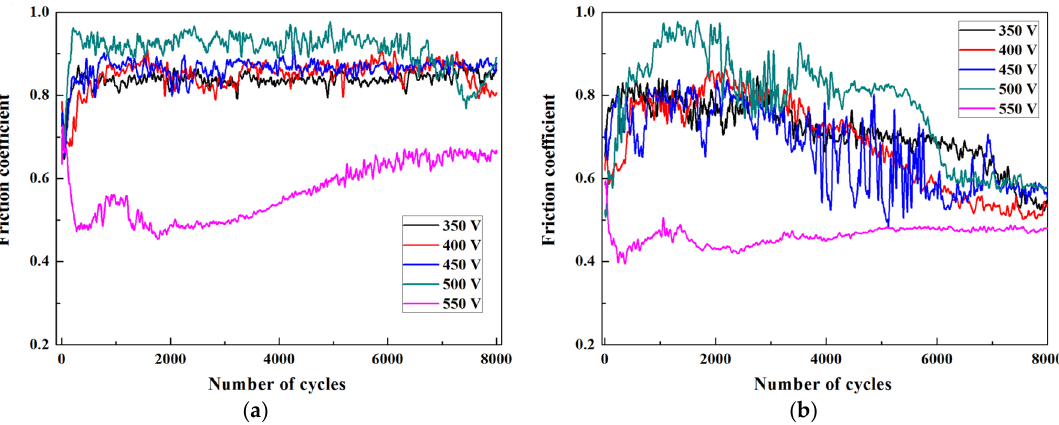
Figure 10. Friction coefficient curves of AlCrN coatings deposited at different charge voltages under ( a ) 600 °C and ( b ) 800